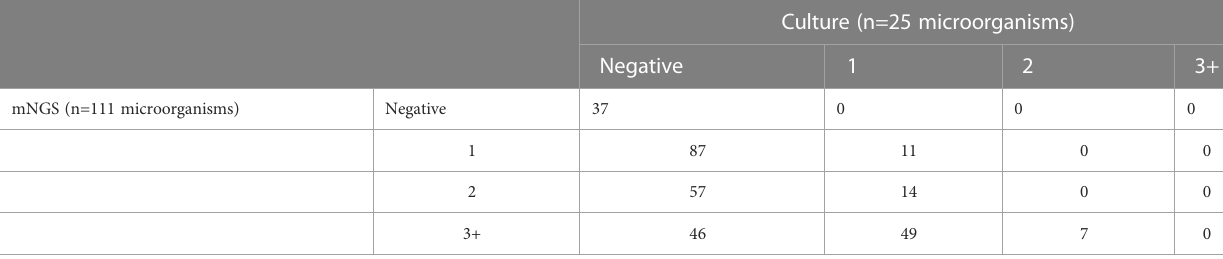
TABLE 2 mNGS and culture results for each specimen: Comparison of microorganisms detected.